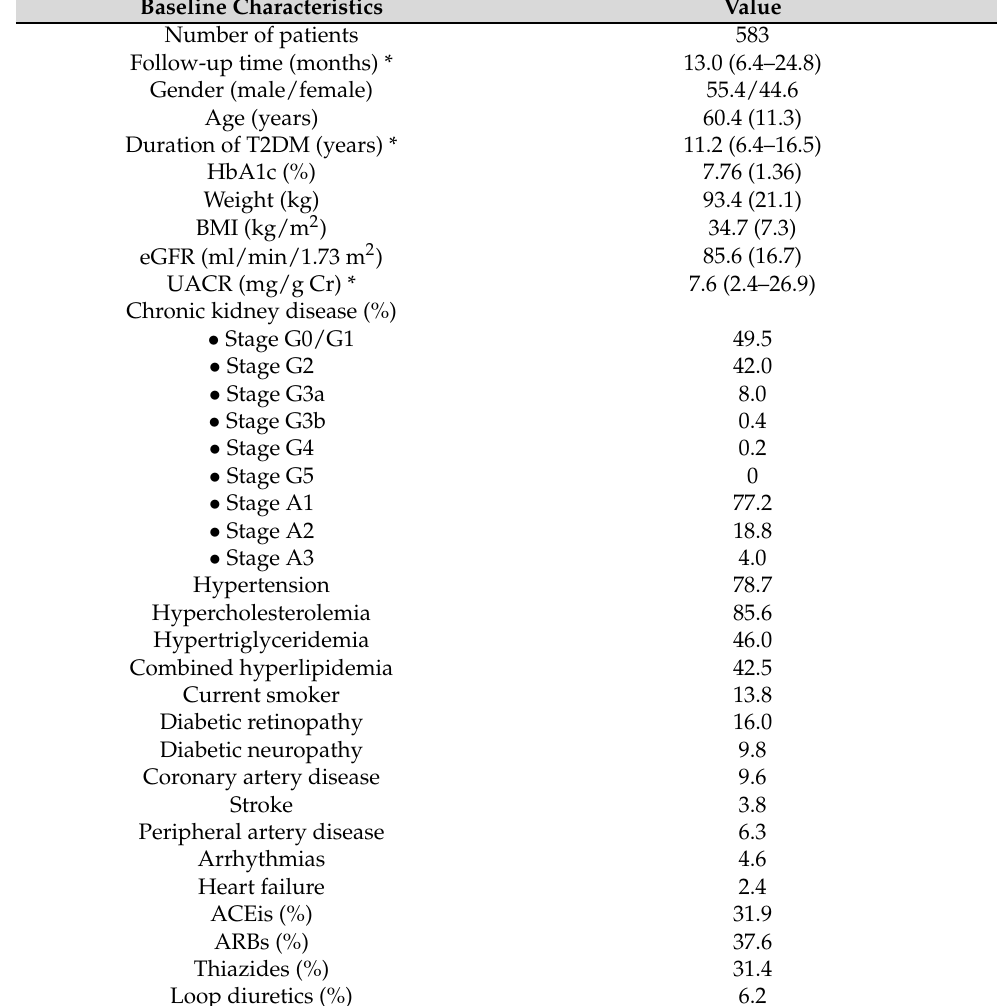
Table 1. Baseline characteristics. Data: percentage or mean (SD), except * median (IQR). BMI: